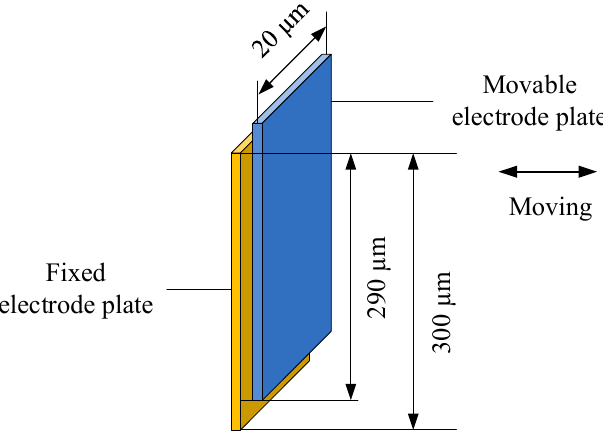
Figure 3. The comb structure in the micro-accelerometer.